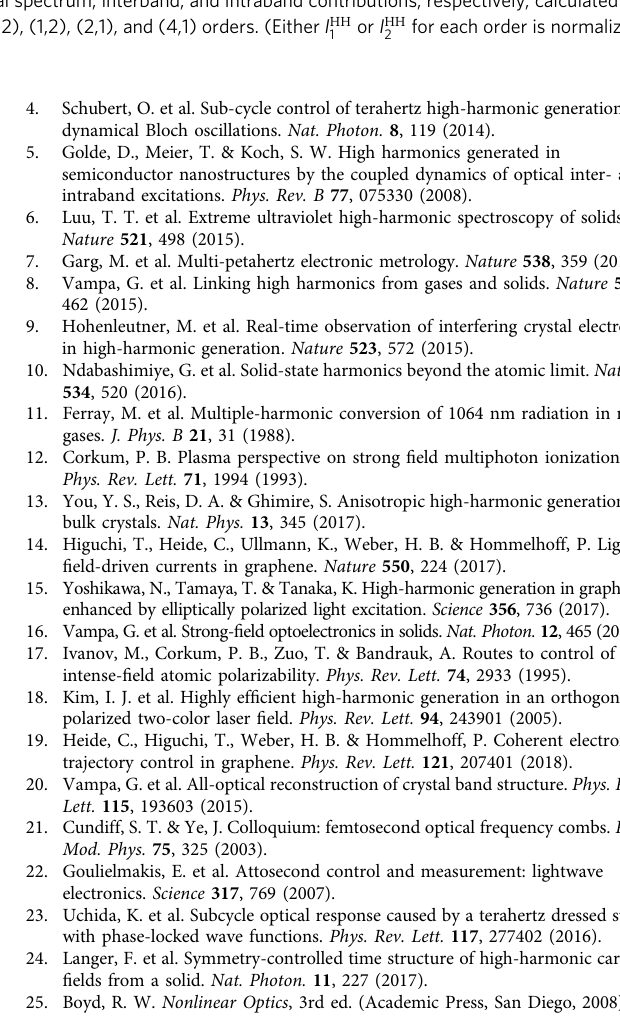
and I HH for the (2,2), (1,2), (2,1), and (4,1) orders. (Either I HH 1 2